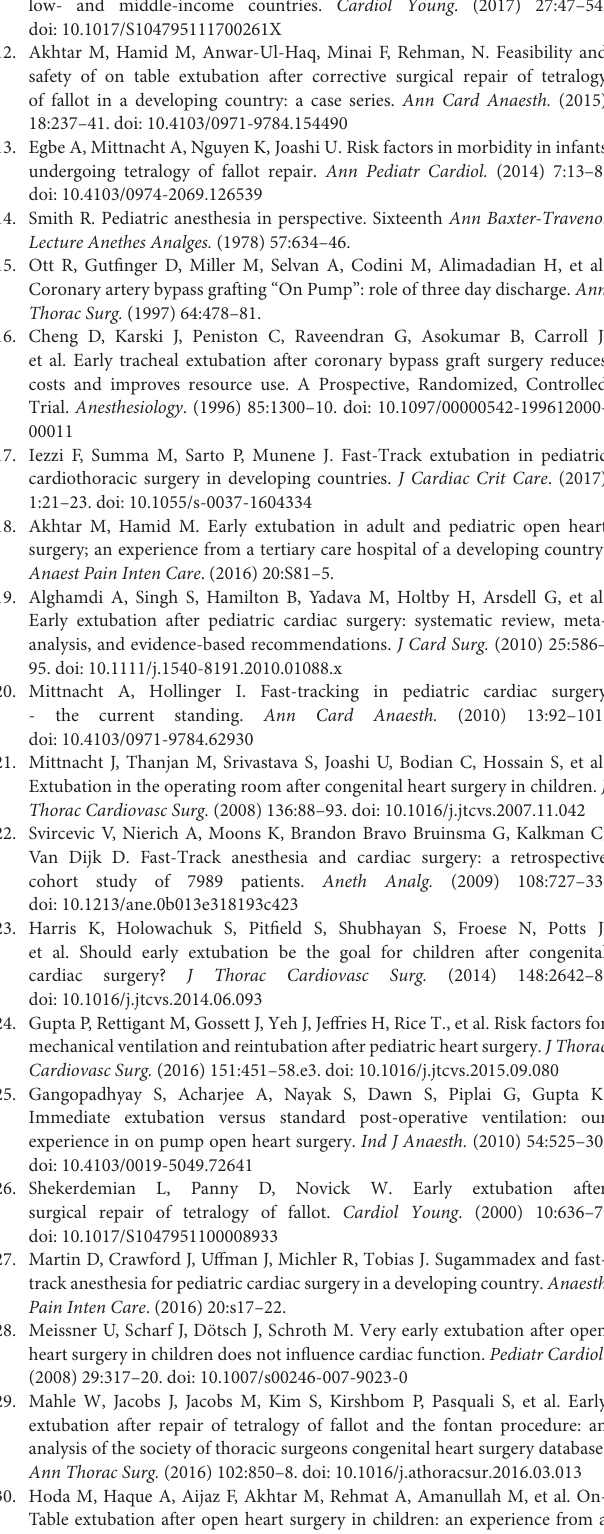
Table extubation after open heart surgery in children: an experience from